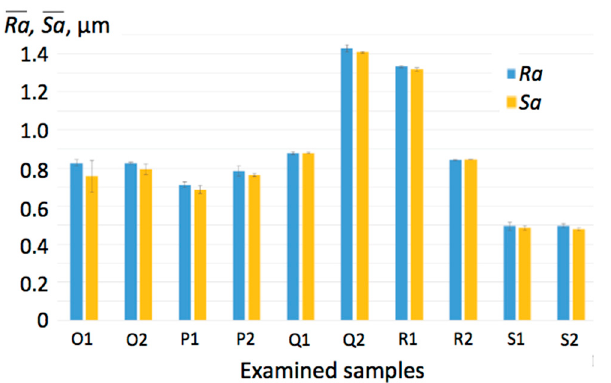
Figure 7. Average results of profile roughness 𝑅𝑎(cid:3364)(cid:3364)(cid:3364)(cid:3364) and respective 3D parameter 𝑆𝑎(cid:3364)(cid:3364)(cid:3364) measurement of the examined